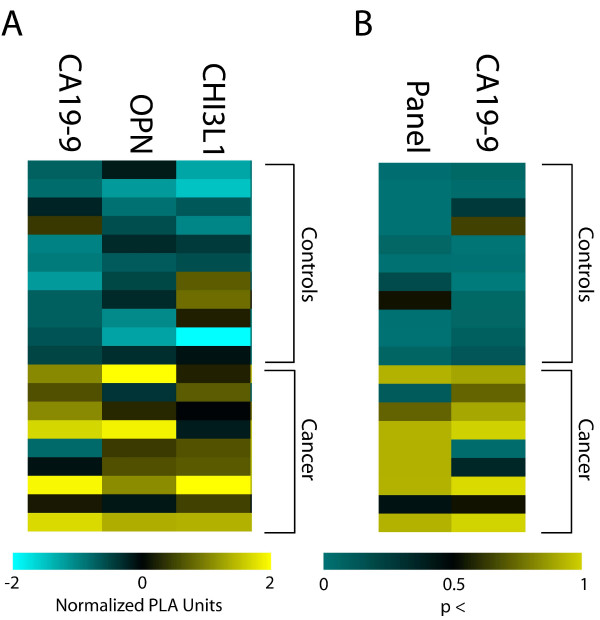
A tumor marker panel consisting of CA19-9, OPN, and CHI3L1 predicts the presence of pancreatic cancer more accurately than CA19-9 alone. (A) Each row corresponds to 1 of 20 randomly assigned pancreatic cancer cases or healthy controls in the test set. Each column represents a tumor marker. Cells depict normalized log2 PLA units. (B) Rows are as A. Columns represent either a three-marker panel consisting of CA19-9, OPN, and CHI3L1, or CA19-9 alone. Cells depict the model-outputted probability that a given sample is either pancreatic cancer or healthy control, with a cutoff of p > 0.5 to be considered pancreatic cancer.